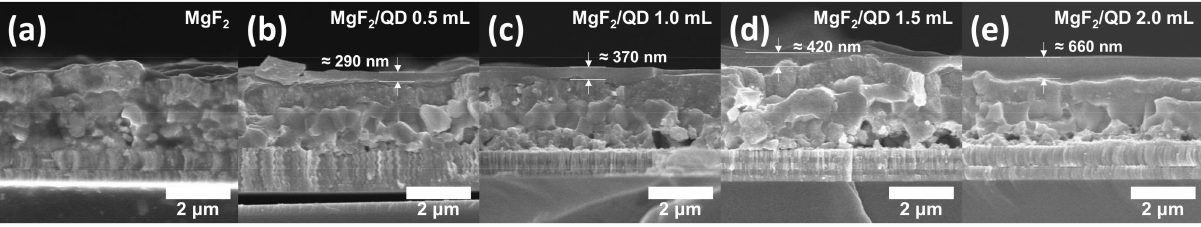
Figure 4. Cross-sectional scanning electron microscopy (SEM) images of CZTSSe solar cells fabricated with QD-based LDS layers: ( a ) MgF 2 , ( b ) MgF 2 /QD 0.5 mL, ( c ) MgF 2 /QD 1.0 mL, ( d ) MgF 2 /QD 1.5 mL, and ( e ) MgF 2 /QD 2.0